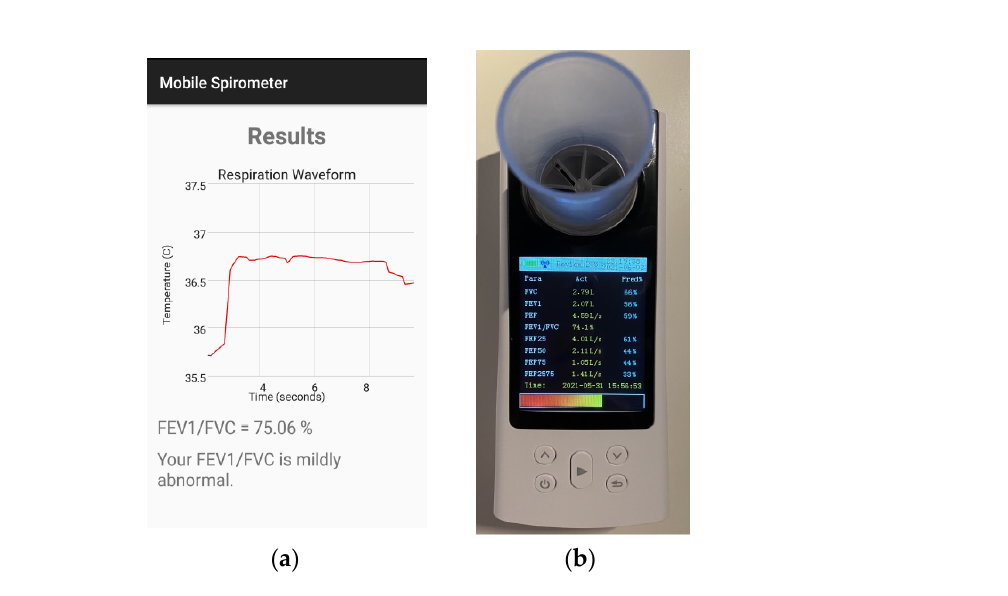
Figure 13. FEV1/FVC measurement ( a ) using the mobile app and ( b ) using the Contec spirometer.